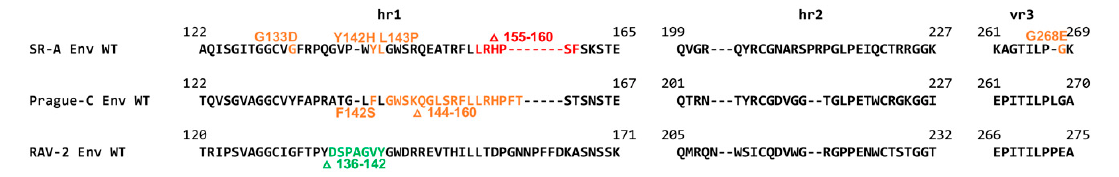
Figure 7. Comparison of the subgroup A and subgroup C ASLV envelope glycoprotein hr1, hr2, and vr3 hypervariable regions. The protein sequence alignments were done using the ClustalW program in MacVector 14.5.3; gaps in the alignment are denoted by (-). The RCASBP(A) vector contains the envelope glycoprotein hypervariable regions from the Schmidt-Ruppin A subgroup A ASLV strain (SR-A Env WT) UniProt P03397; the RCASBP(C) vector contains the envelope glycoprotein hypervariable regions from the Prague-C subgroup C ASLV (Prague C Env WT) Genbank AAB59934.1. The mutations selected and characterized in this study are highlighted in orange; the original RCASBP(A) Δ 155–160 mutation is highlighted in red. The results from this study are compared to the ASLV(B) hr1, hr2, and vr3 regions of Rous associated virus-2 (RAV-2) Genbank AAA87241. Selection of a mutant RAV-2 that was able to infect avian cells that lacked a Tvb receptor had a deletion in hr1 residues 136–142 ( Δ 136–142) highlighted in green [36].